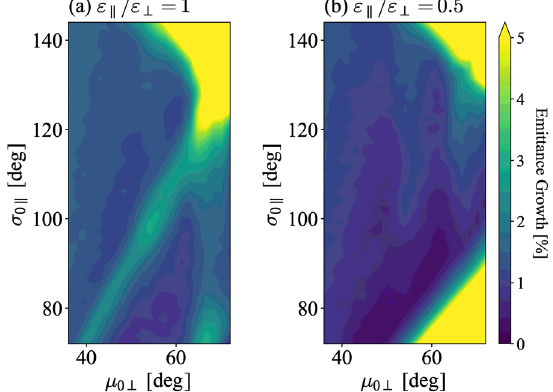
FIG. 10. W ARP simulation results obtained under the initial conditions (a) ε k = ε ⊥ ¼ 1 and (b) ε k = ε ⊥ ¼ 0 . 5 . The largest emittance growth of the three directions is taken to choose the color at each operating point. The result in Fig. 7 is replotted in the left panel (a) for comparison. We have changed the initial emittance ratio ε k = ε ⊥ from 1.0 to 0.5 in the right panel (b), maintaining the beam